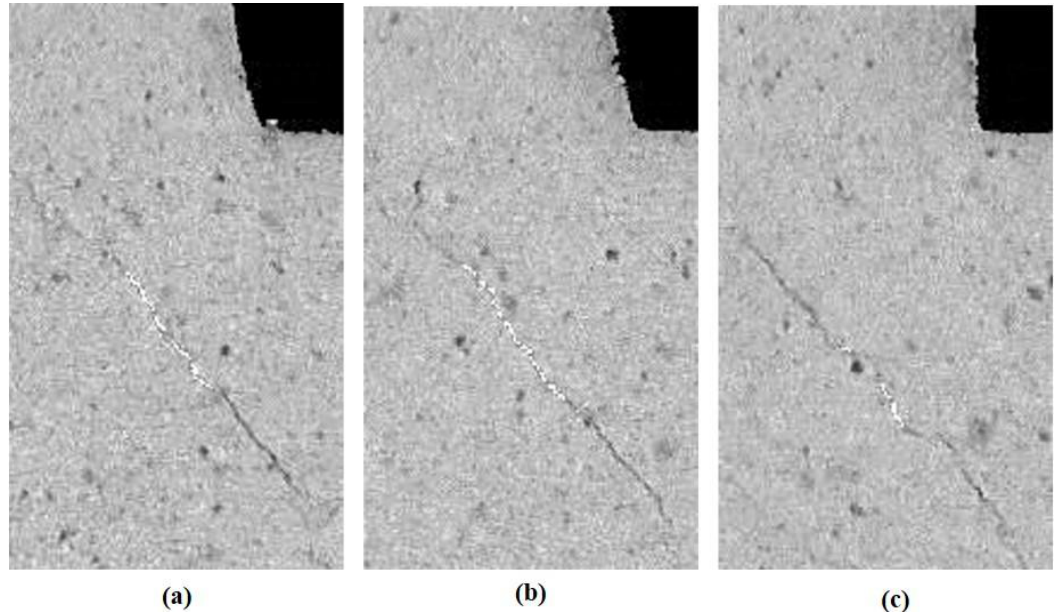
Figure 14. 2D views of the percolated region (white) on partial anode block: ( a ) image located near the left end of the partial anode block; ( b ) image located at the mid width (135 mm) of the partial anode block; ( c ) image located near the right end of the partial anode block.